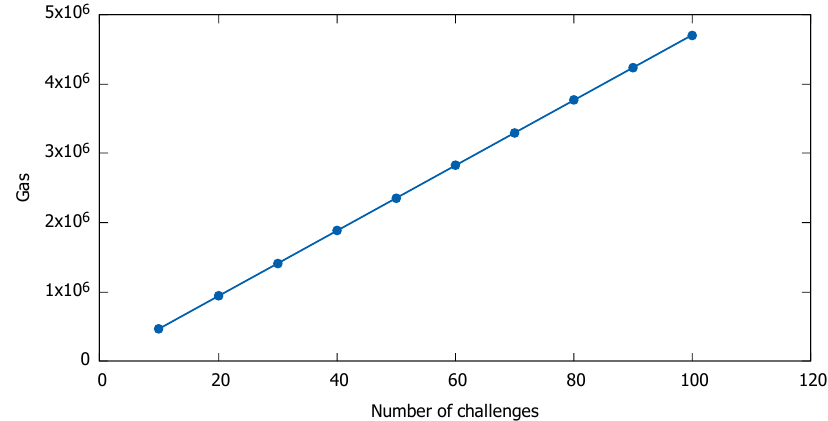
Figure 3. Ethereum gas consumption as a function of the number of